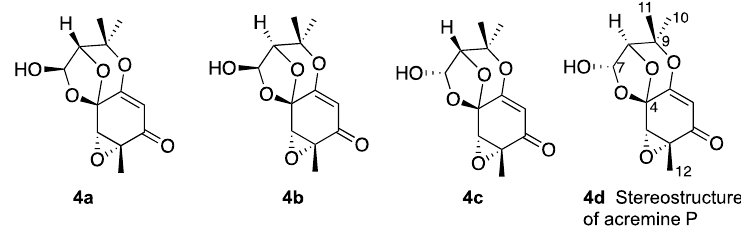
Figure 1. Three-dimensional image of stereoisomer 4d showing nOe to Me-11.